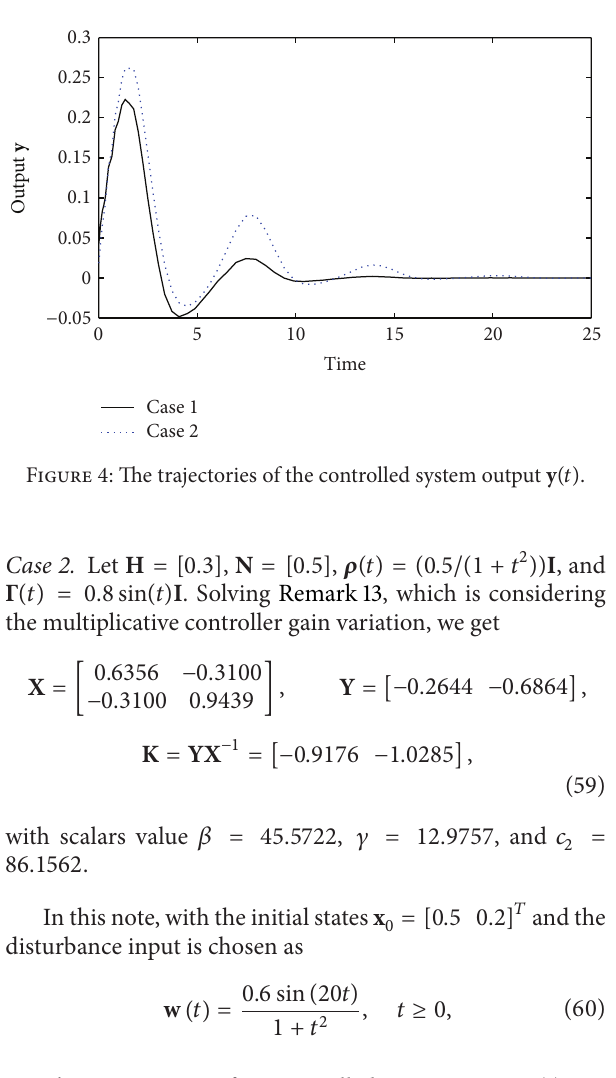
Figure 5: The response of the controlled system for x T (𝑡) Rx (𝑡) ( 𝑡 ∈ [ 0 𝑇 ]